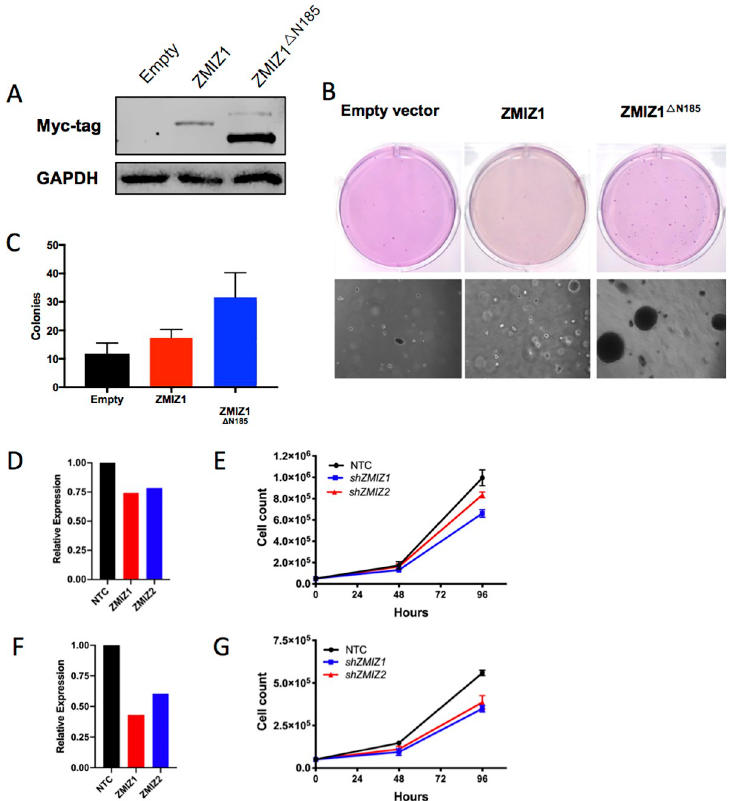
Fig 7. ZMIZ1 4 N185 expression transforms immortalized keratinocytes. HaCaT cells were transfected with a Myc- tagged cDNA for full length or the truncated ZMIZ1 4 N185 isoform ( A ) and protein expression was confirmed using a Myc antibody. ( B ) Colony-formation assays showed that HaCaT cells with ZMIZ1 4 N185 expression form a greater number of colonies (top inset) and larger colonies (bottom inset) relative to HaCaT cells expressing the myc-tagged full length ZMIZ1 or empty vector control. Depletion of ZMIZ1 and ZMIZ2 in cuSCC cell lines decreases cell proliferation. Stable shRNA-mediated depletion of ZMIZ1 or ZMIZ22 in human cuSCC cell lines ( D-E ) A431 or (F-G) COLO16 confirmed by TaqMan analysis relative to cells transduced with a non-targeting shRNA (NTC). ZMIZ1 or ZMIZ2 depletion resulted in significantly decreased cellular proliferation in ( E ) A431 cells (overall P < 0.0001; shNTC vs. sh ZMIZ1 q < 0.0001; shNTC vs. sh ZMIZ2 q = 0.003; sh ZMIZ 1 vs. shZMIZ2 q = 0.0023). ( F ) COLO16 (overall P = 0.0005; shNTC vs. sh ZMIZ1 q < 0.0001; shNTC vs. sh ZMIZ2 q < 0.0001; sh ZMIZ1 vs. sh ZMIZ2 q = 0.18). Statistical significance measured by 2-factor ANOVA followed by multiple pairwise comparisons and